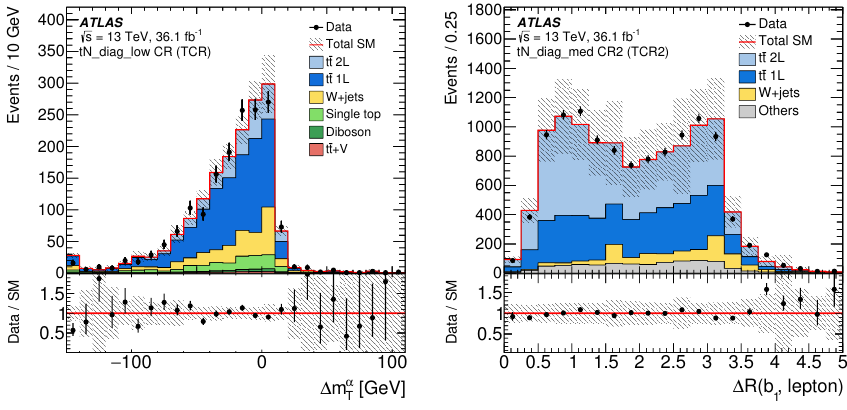
Figure 10 . Kinematic distributions in the tN diag low and tN diag med control regions: (left) (cid:1) m (cid:11) in the tN diag low top control region (TCR) and (right) (cid:1) R ( b 1 ; ‘ ) in the tN diag med top T control region (TCR2). Values of m ~ = 200 GeV and m = 27 GeV are used, resulting in (cid:11) = 0 : 135. t 1 ~ (cid:31) 0 1 The t (cid:22) t background is scaled by a normalisation factor obtained from the control region. The category labelled ‘Others’ stands for minor SM backgrounds that contribute less than 5% of the total SM background. The hatched area around the total SM prediction and the hatched band in the Data/SM ratio include statistical and experimental uncertainties. The last bin contains